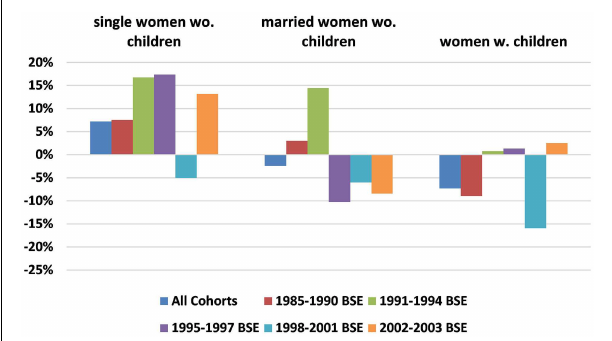
FIGURE 7 | Gender gap in retention in engineering by family-status of women at 7–8 years post-BSE for BSEs working full-time (comparison group: men working full-time). Data Source: NSF SESTAT Surveys